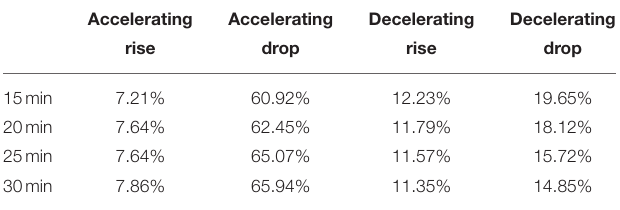
TABLE 3 | Distribution of AD patients after SBP classification.